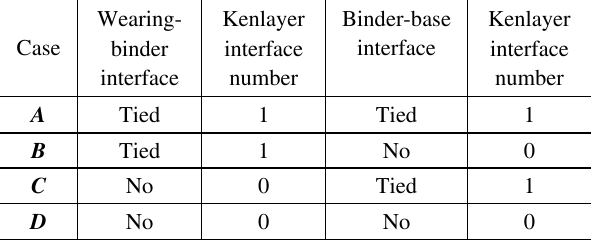
Table 2 . Interface condition in this research